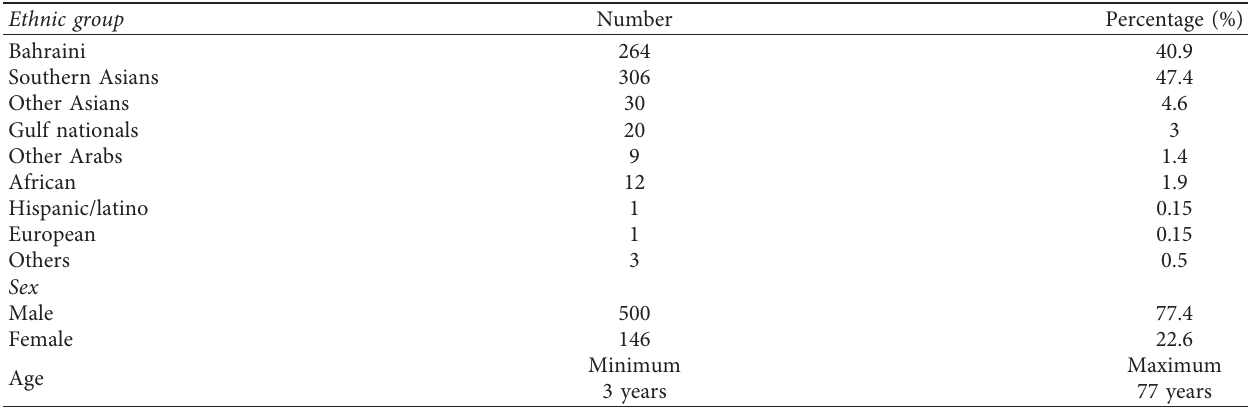
Table 1: Demographic data of participants.